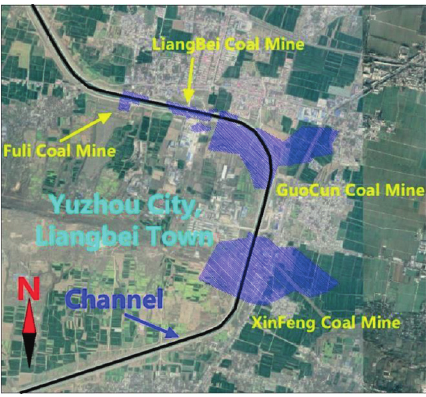
Figure 1: Location of channel and coal mine goaf.